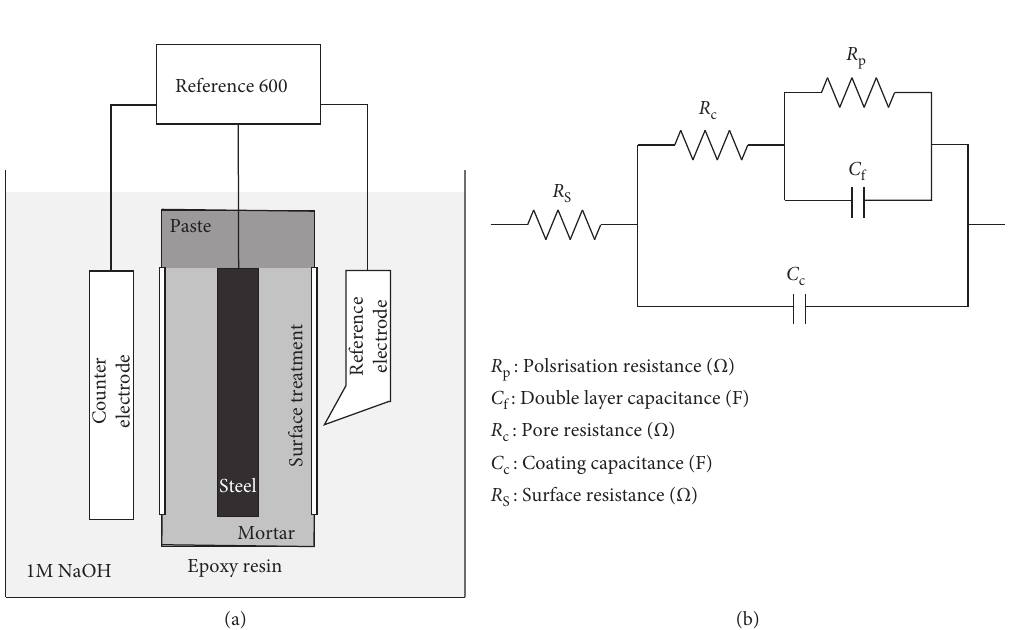
Figure 2: Process of BSE image analysis.